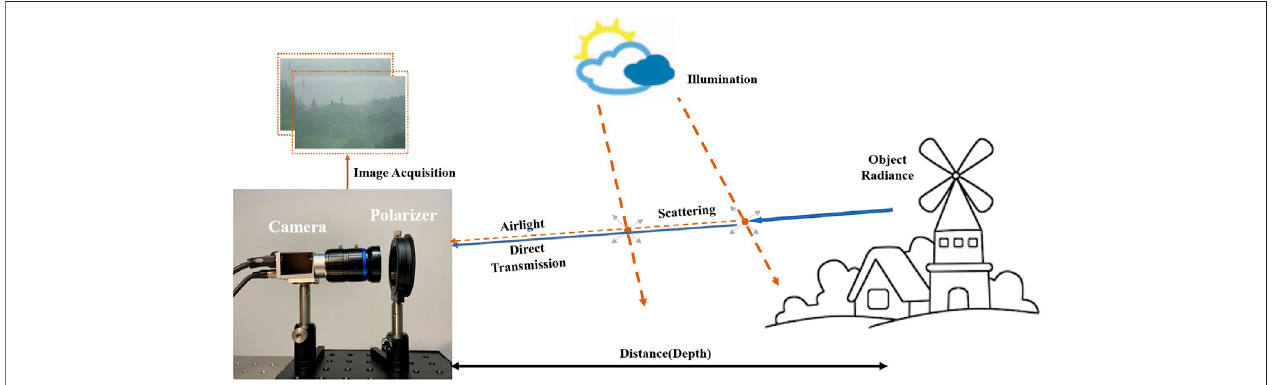
FIGURE1| Schematicdiagramofscatteringmodelanddatacollectionprocess.Theilluminationlight(suchasthesunlight)isscatteredbyatmosphericparticlesas airlight. The intensity of airlight increases as the distance increases and the object radiance is scattered and attenuated along the optical path. Two scenes with orthogonal polarization states are collected by rotating the front polarizer of the